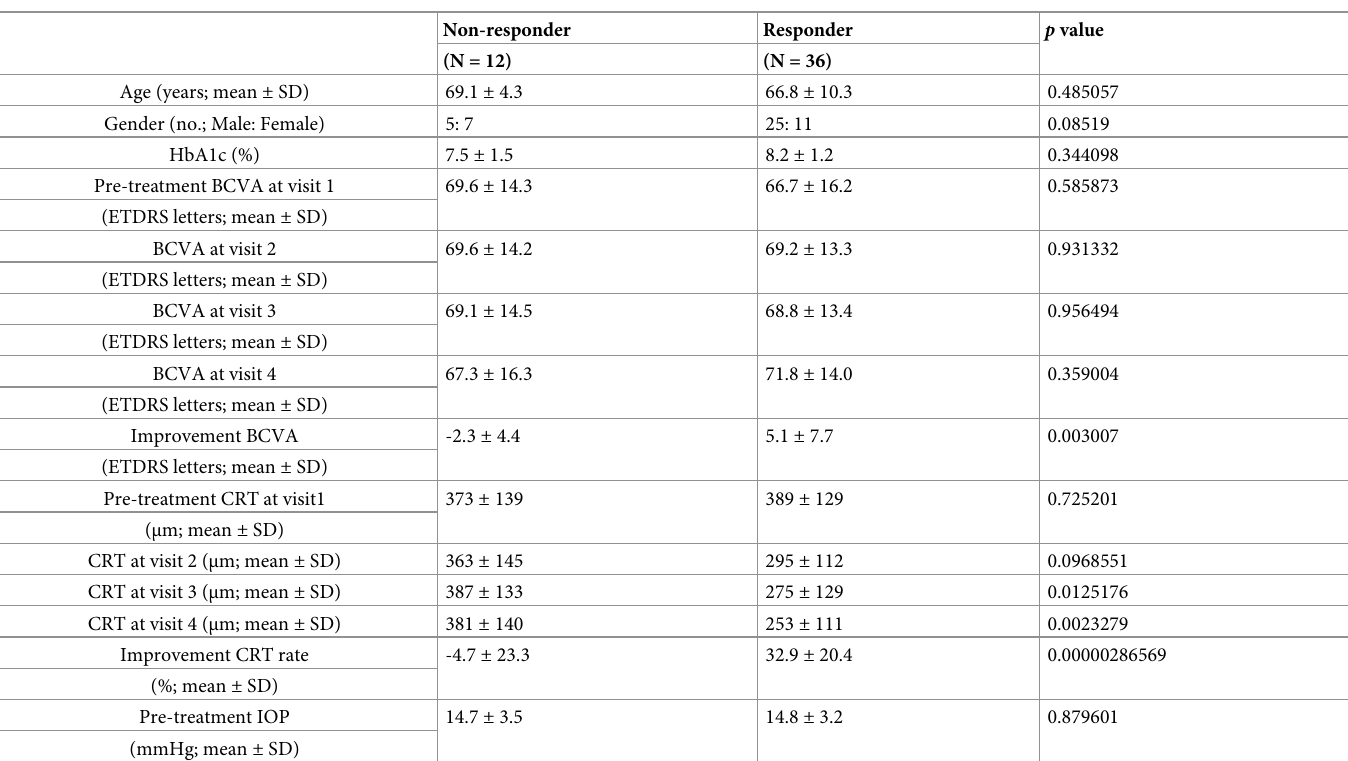
Table 2. Characteristics.